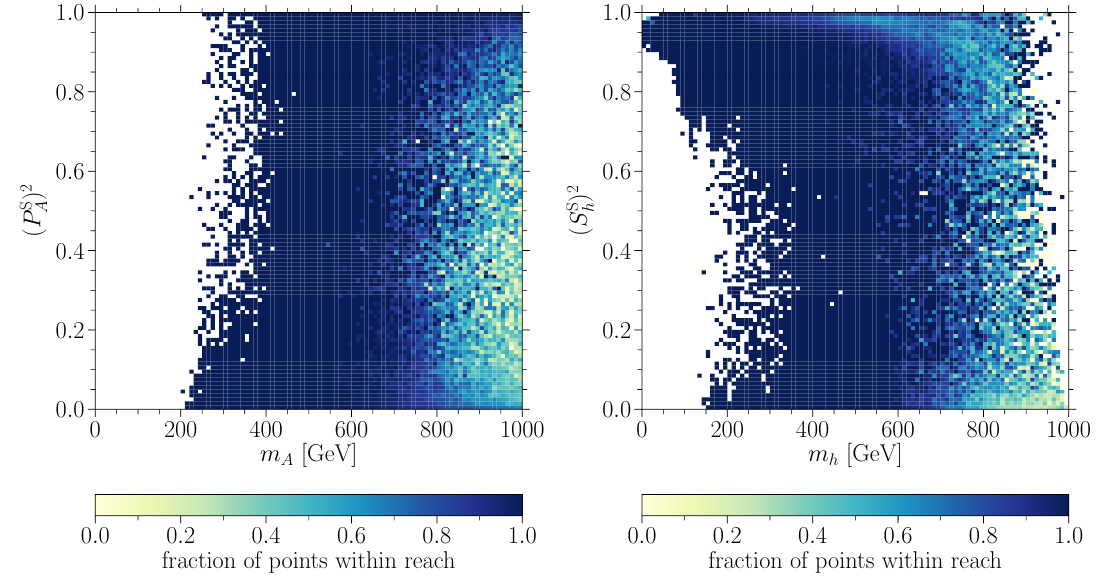
Figure 9 . The left [right] panel shows the distribution of LHC sensitivity in the plane of the mass m A [ m h ] and the singlet fraction ( P S